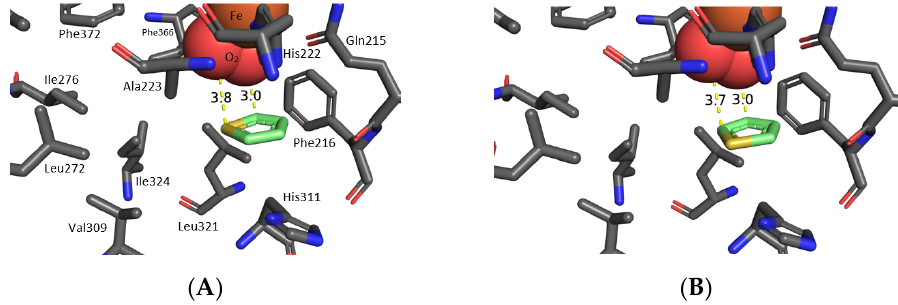
Figure 1. Preferred orientation of thiophene 1a for TDO-catalyzed: sulfoxidation ( A ) and cis -dihydroxylation ( B ).